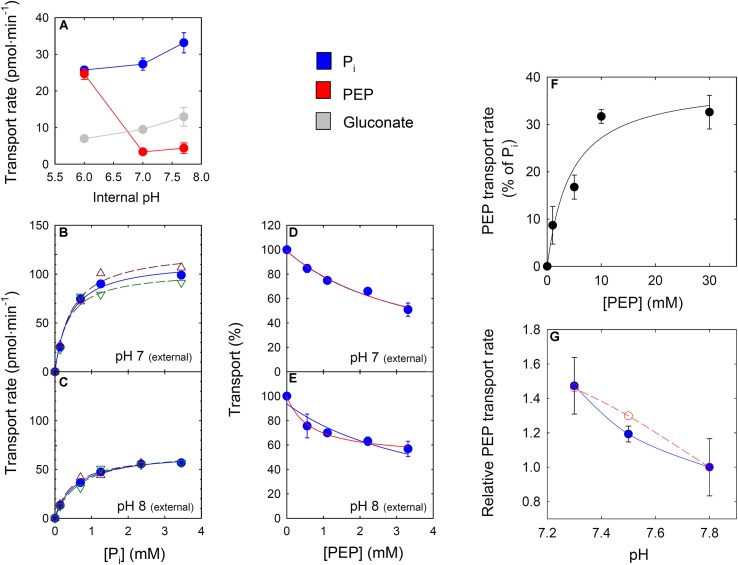
Kinetic properties of the heterologously expressed XPT protein or of leaf extracts in the proteoliposome system. In (A) the internal space of the proteoliposomes was preloaded either with PEP (red circles), Pi (blue circles) or gluconate (light grey circles) (30 mM each) adjusted to pH values of 7.8, 7.0 and 6.0. The transport kinetic was initiated by adding 0.14 mM 32P labeled Pi as a counter-exchange substrate at pH 7.5. In (B,C) substrate saturation kinetics with radiolabeled Pi at either pH 7.0 or pH 8.0 outside of the proteoliposomes (inside pH 7.8) are shown. The red or green open triangles represent individual measurement, whereas the closed circles indicate the mean values. In (D,E) inhibition kinetics of Pi import (0.14 mM) by increasing concentrations of PEP are shown. Curves were fitted to the experimental data (mean of two experiments) under the assumption that the hyperbolic decay curve approaches a transport rate of zero at infinite PEP concentrations (blue line) or the decay curve intercepts the transport axis in the positive range (red line). Both curve fits resulted in an identical (D) or a substantial different curvature (E). In (F) proteoliposomes containing membrane proteins from Col-0 leaf extracts were preloaded with increasing PEP concentrations balanced with gluconate to maintain a constant osmolarity. Pi counter-exchange was initiated by the addition of 32P-labeled Pi (0.14 mM). From the hyperbolic curve fit a Km-value for PEP of 4.34 ± 2.6 mM was determined. In (G) a dependency of Pi/PEP counter-exchange from the internal pH inside the proteoliposomes at a total PEP concentration of 3 mM is shown. The blue symbols and line indicate the experimental data, whereas the red circles and line were predicted for counter-exchange rates, assuming that two-fold negatively charged PEP2- represents the transported PEP species.